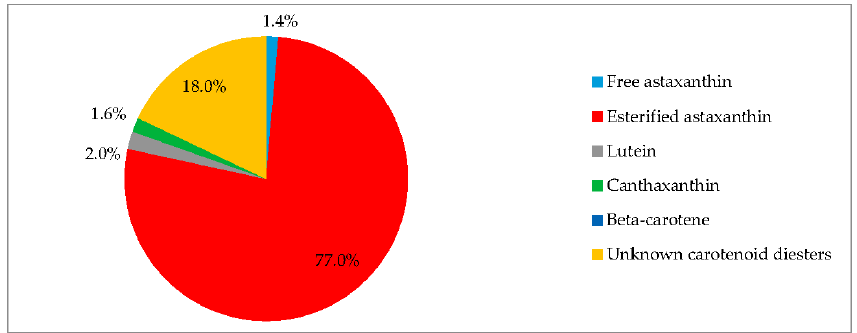
Figure 8. Pigment profile of H. pluvialis red motile macrozooids. Samples were cultured in EG:JM in the green stage, followed by medium without nitrate in the red stage (20 °C, continuous light at 240 µmol photons m − 2 ·s − 1 ).